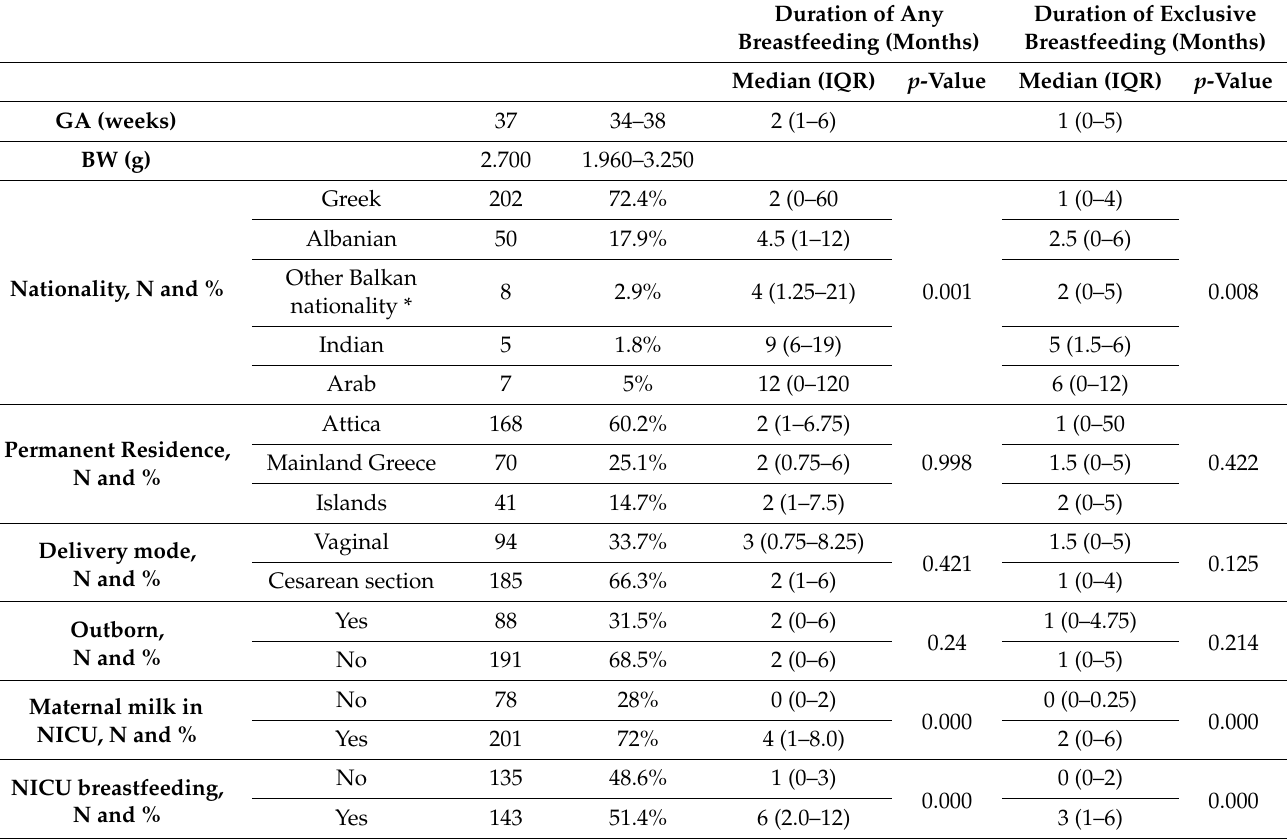
Table 1. Characteristics of the study population and median duration of any and exclusive breast- feeding (in